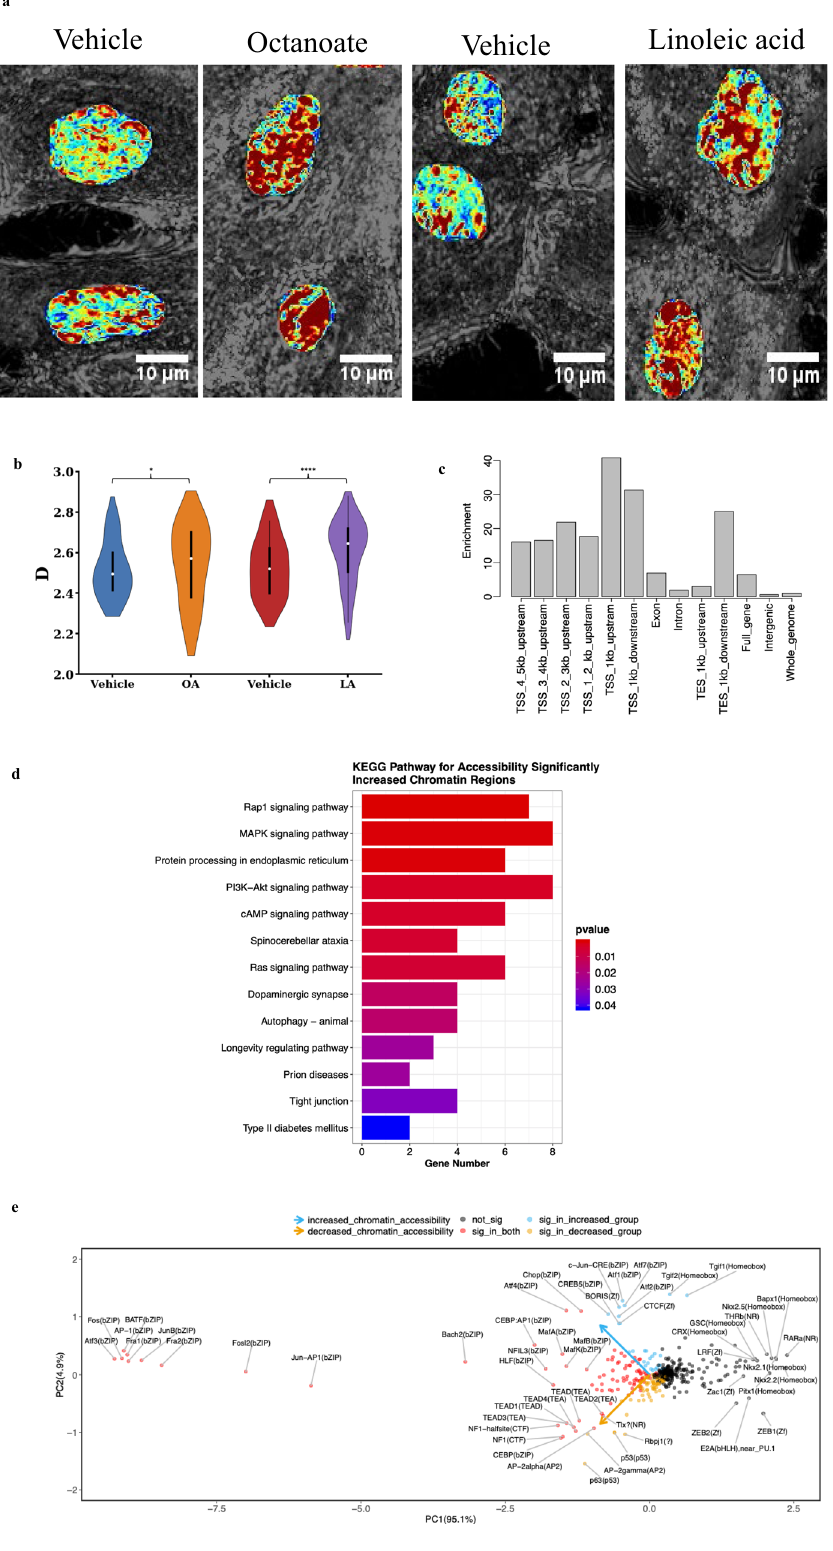
with participants comprised of 28 matched triplets of women with ER-positive breast cancer, ER-negative breast cancer, and reduc- tion mammoplasty controls. The three groups were matched by age, race, and menopausal status as shown in